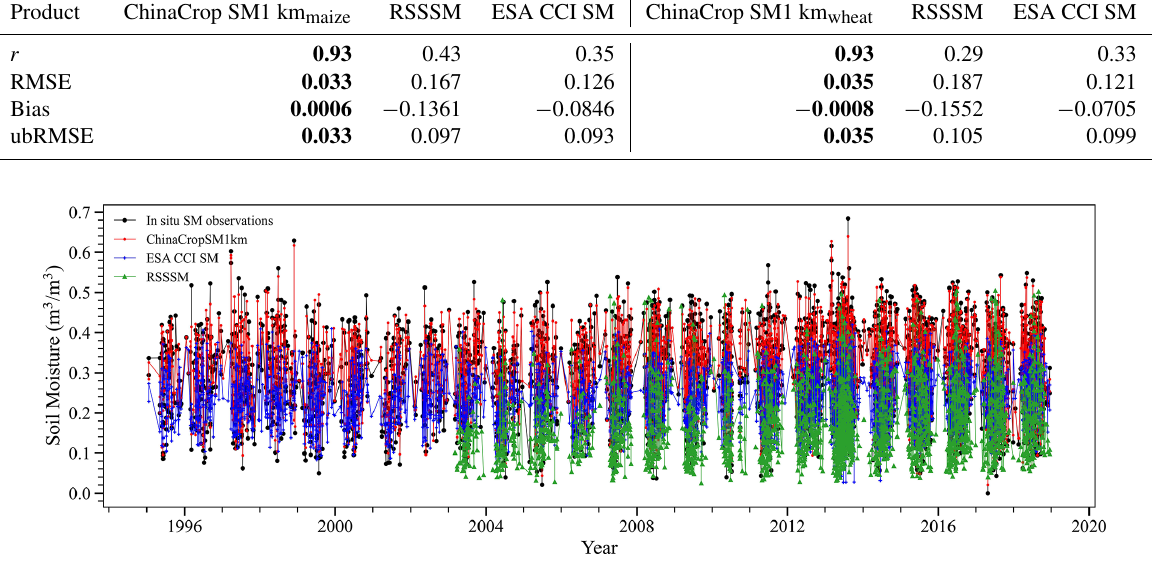
Figure 8. Time series of comparison between in situ SM observations and